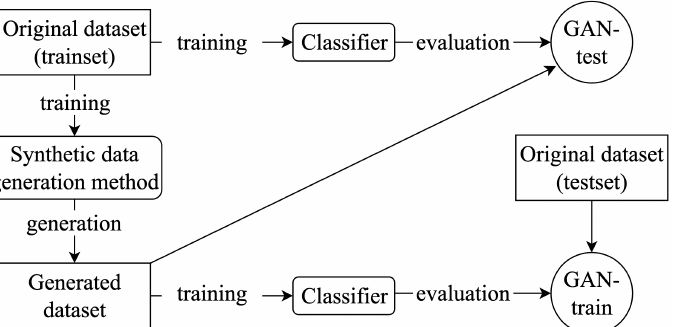
Figure 26. A diagram representing the GAN-train and GAN-test metrics. The GAN-train is a measure consisting of the accuracy of a classifier trained in the generated data and evaluated in the real data. GAN-test learns on the real data and is evaluated in the generated data. Image based on